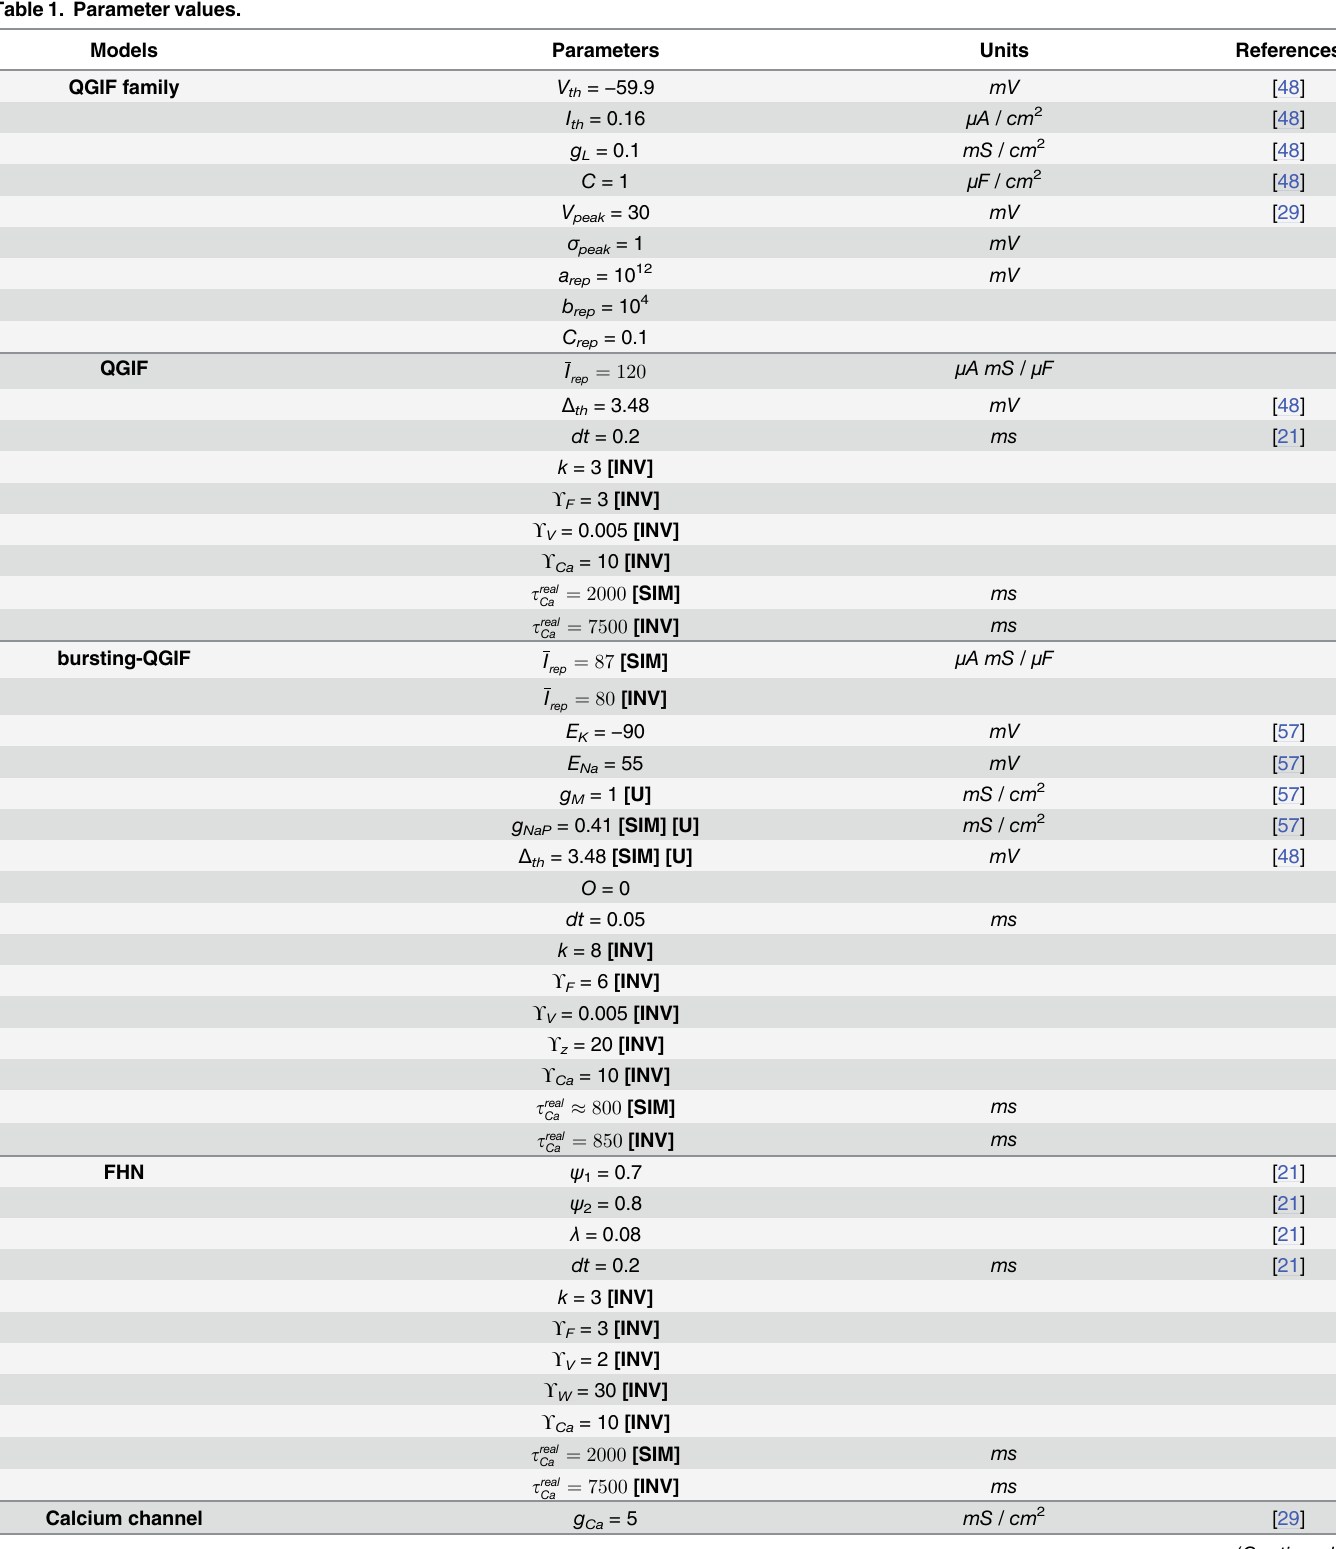
Table 1. Parameter